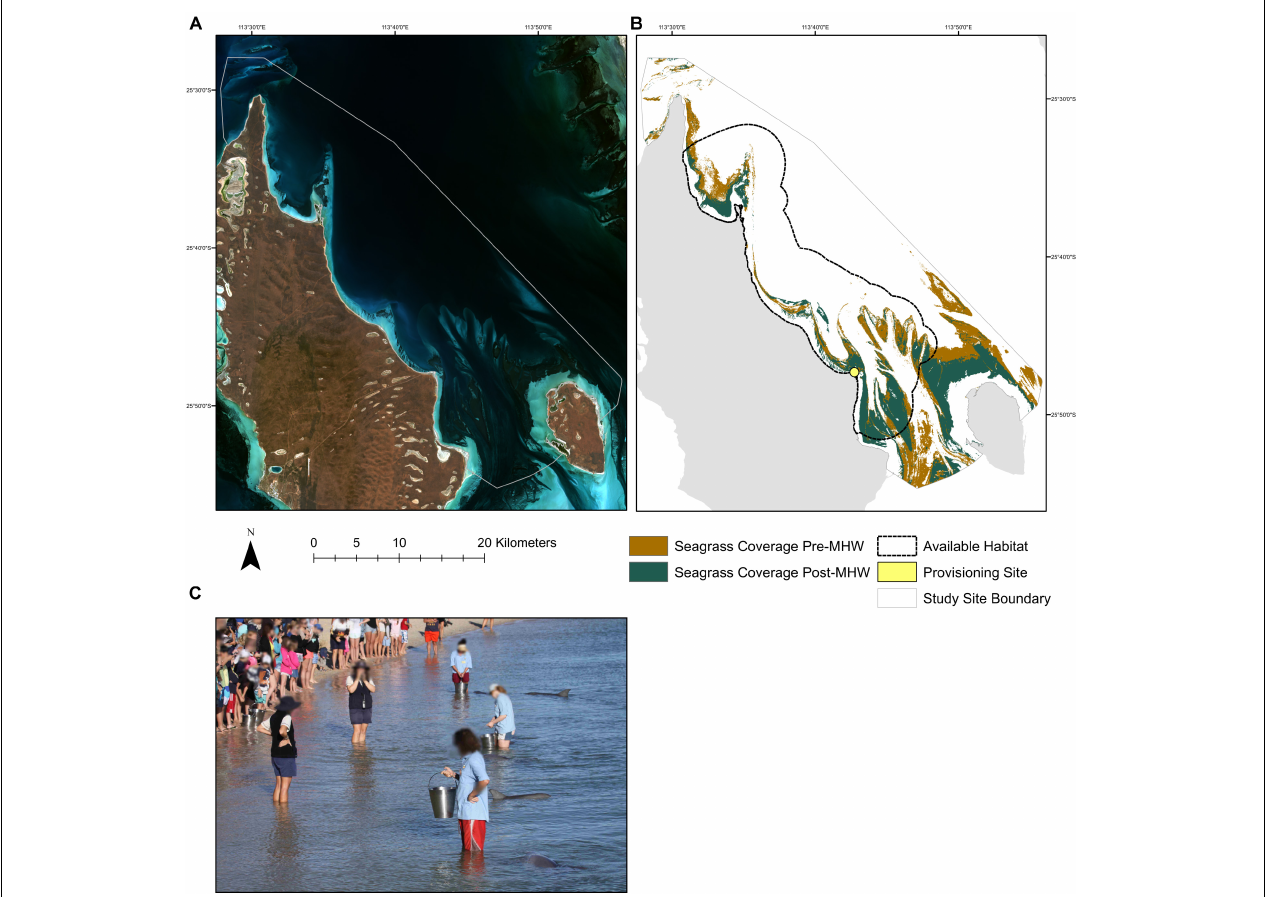
FIGURE 1 | The location of the study site and provisioning scene. (A) Landsat-8 imagery of the study site from June 2015 courtesy of United States Geological Survey. (B) Map of the study area showing the extent of seagrass beds before and after the MHW. The boundaries of the study area represent the intersection of the minimum convex hulls around all survey effort during each time period ( pre-MHW, 1994–2010; peri-MHW, 2011–2015; post-MHW, 2016–2019). The dotted black line represents the area of available habitat for dolphins in our study. The provisioning site is shown by the yellow circle located at S 25 ◦ 47 (cid:48) 52.4 (cid:48)(cid:48) , E 113 ◦ 43 (cid:48) 12.9 (cid:48)(cid:48) . (C) Image from a feed in 2015, Photo Credit: Ewa